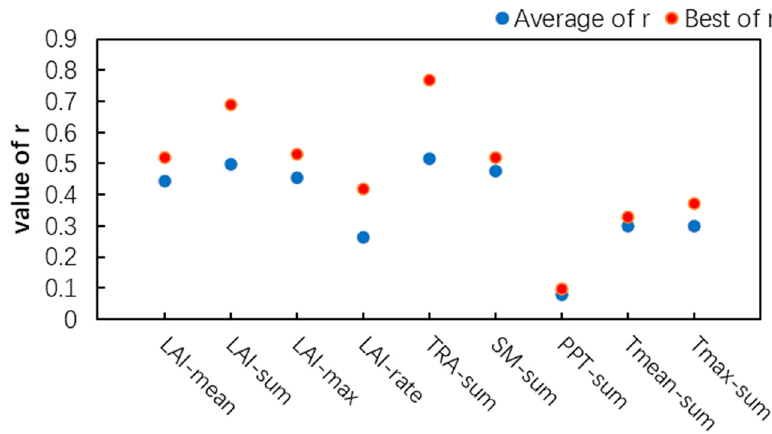
Figure 7. Comprehensive Performance of Each Feature.